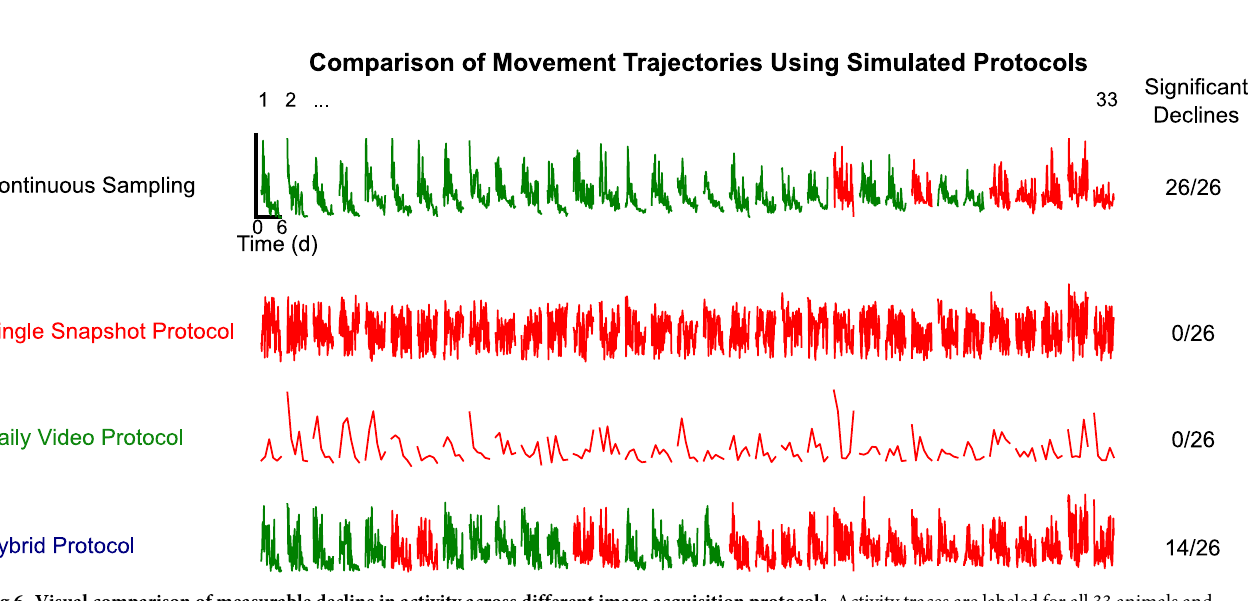
Fig 6. Visual comparison of measurable decline in activity across different image acquisition protocols. Activity traces are labeled for all 33 animals and colored red vs. green to denote non-significant vs. significant decline, respectively (ordering of animals as in Fig 3E).